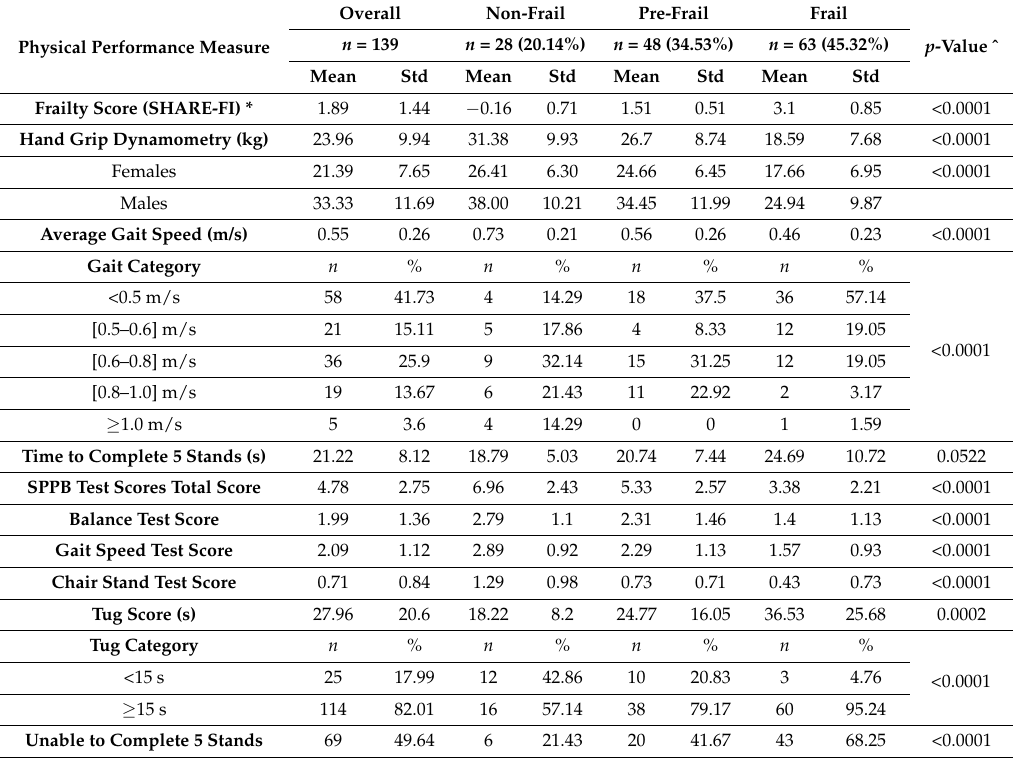
Table 2. Summary Statistics on Physical Performance